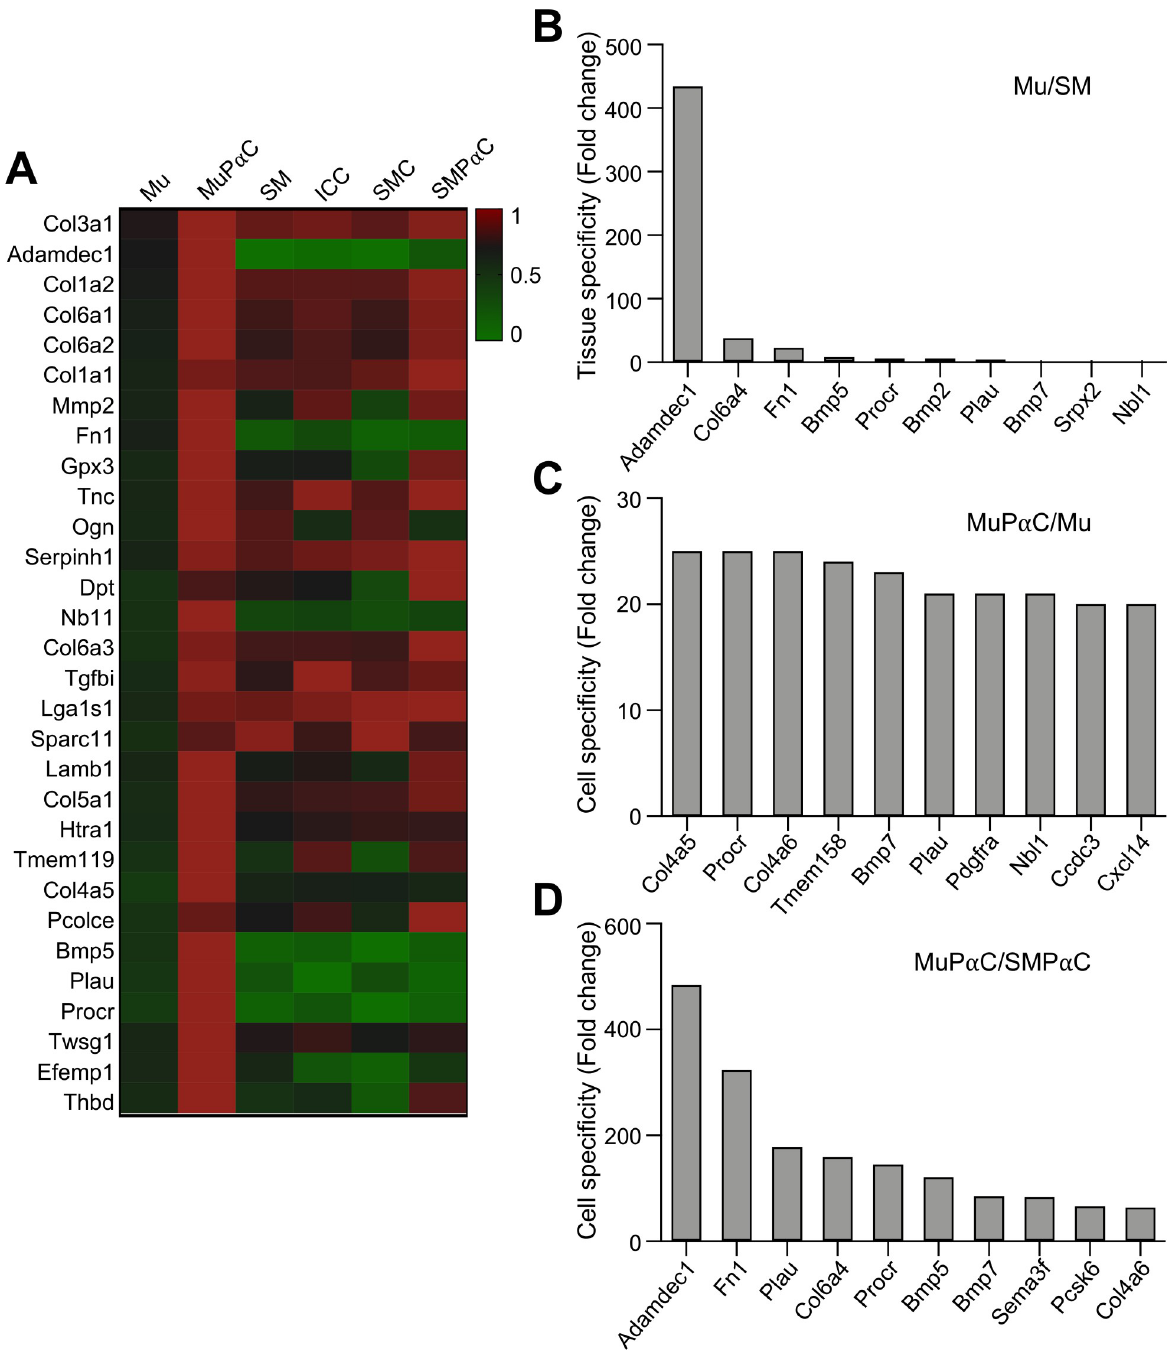
Fig 2. Identification of genes expressed in isolated colonic MuP α C. A : A heat map of genes expressed in colonic MuP α C compared to colonic mucosa (Mu), colonic smooth muscle (SM), interstitial cells of Cajal (ICC), smooth muscle cells (SMC), and smooth muscle PDGFR α + cells (SMP α C). Col3a1 and Adamdec1 are highly expressed in colonic MuP α C. B : Colonic Mu-specific genes compared to colonic SM. C : MuP α C- specific genes compared to Mu. D : Colonic MuP α C-specific genes compared to colonic SMP α